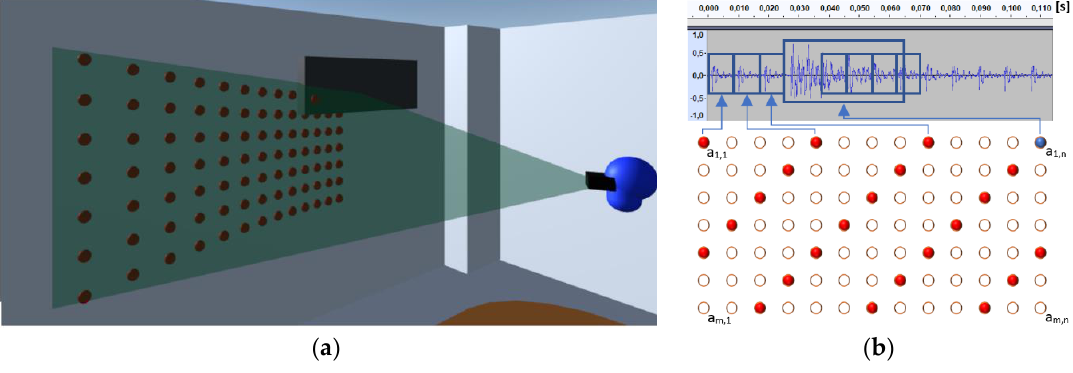
Figure 4. Projected VAS. ( a ) Spawn positions of virtual audio sources. ( b ) S(t) acoustic output corresponding to ( a ), k = 4, in the first low-resolution image (T 1 ).